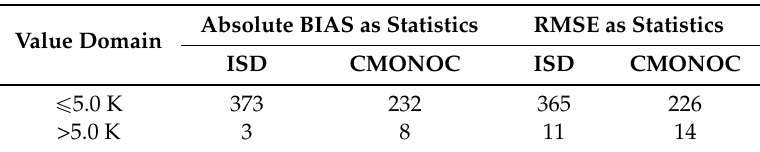
Table 2. Number of sites at which absolute BIAS or RMSE of interpolated surface air temperature were within a given special value domain.